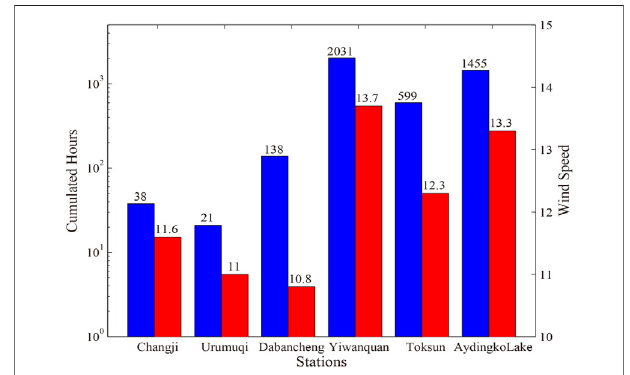
FIGURE 2 | Occurrence frequency of HWHs and their mean intensity (in terms of horizontal wind speed) at the six automatic weather stations during 2017 –